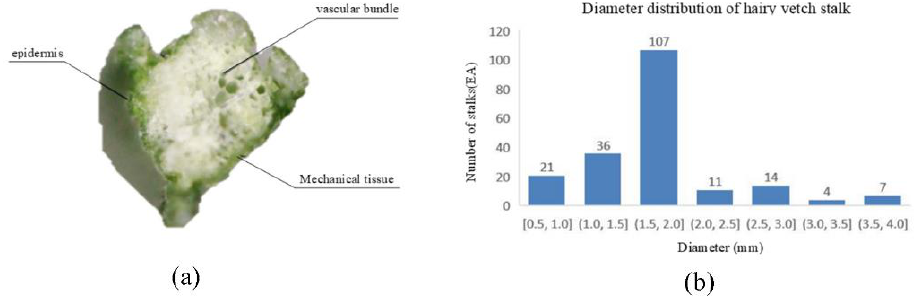
Figure 2. Diameter distribution of hairy vetch stems. ( a ) Structure of hairy vetch’s stem; ( b ) Diameter distribution of hairy vetch stems.